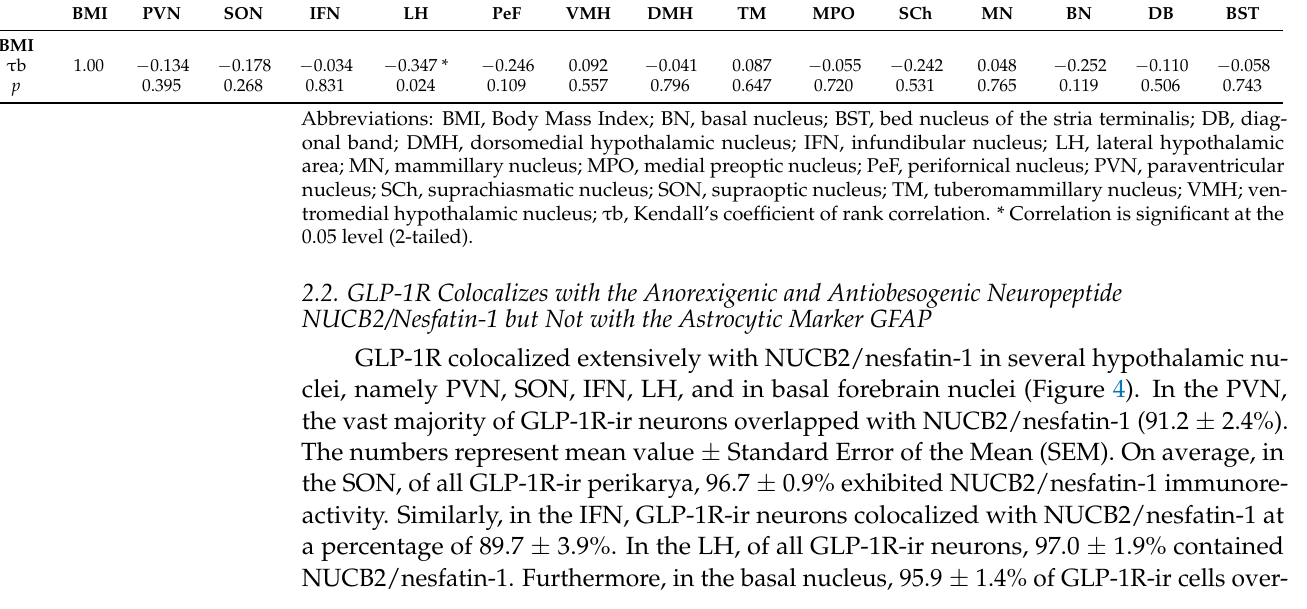
Table 3. Correlations between BMI and immunoexpression of GLP-1R in human hypothalamic nuclei. Kendall’s Tau-b Correlation